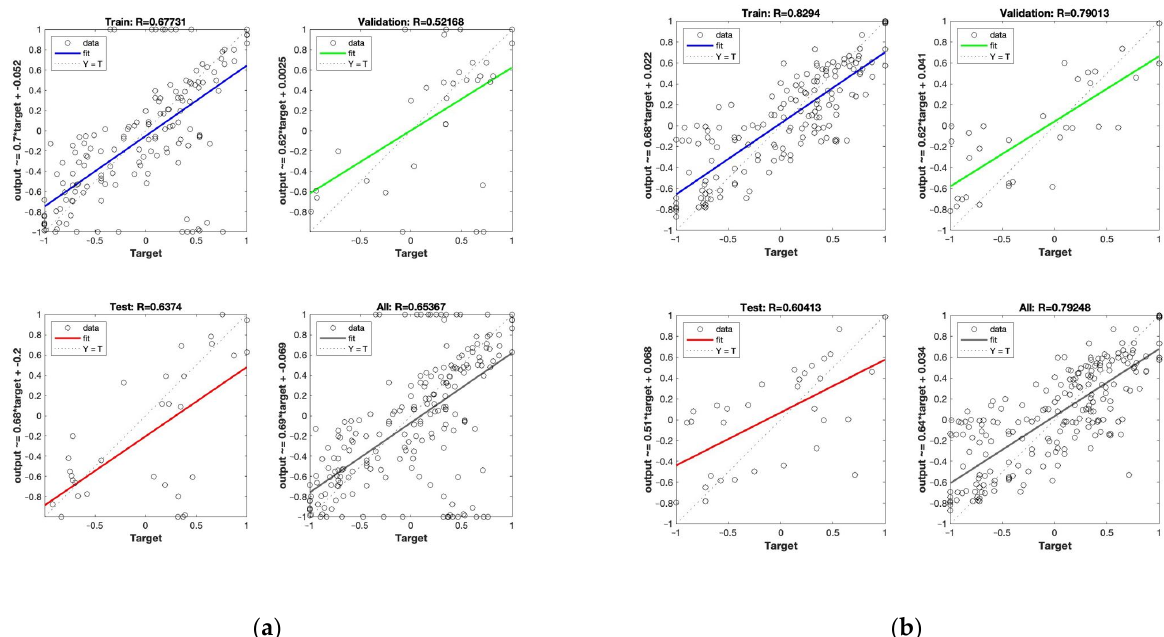
Figure 8. ( a , b ) are two graphs showing the relationship between the training set, the validation set, and the test set predicted value and the actual value when the BP and CPA-BP model predicts the surface roughness (Rmax) of plywood.